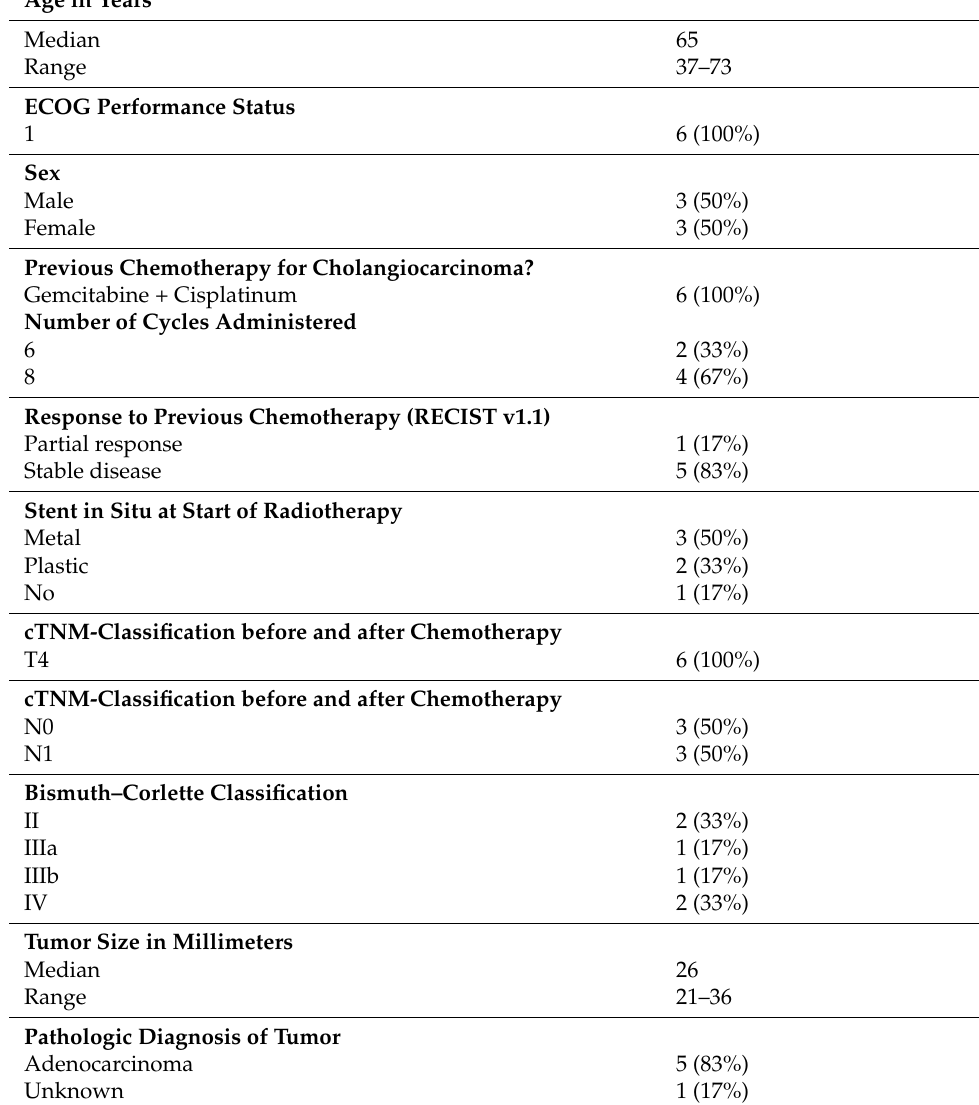
Table 3. Baseline